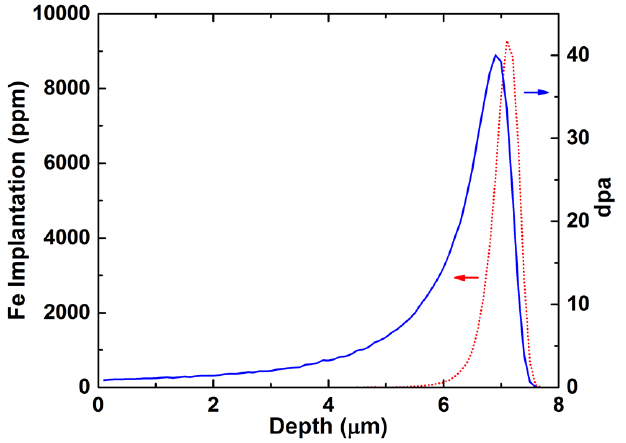
Figure 3. Implanted Fe ion concentration (in ppm) and radiation damage (in dpa) of the irradiated MA957 tensile sample.